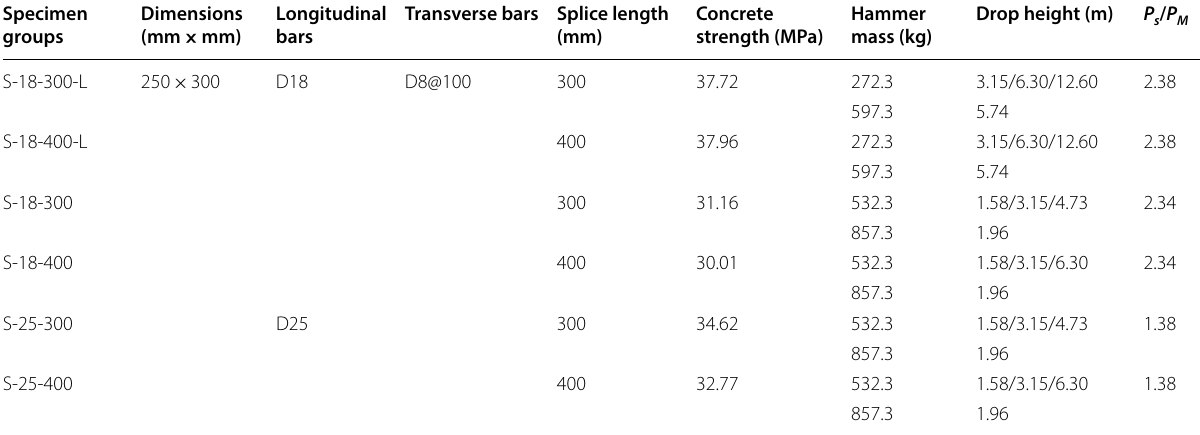
Table 1 Summary of test program.